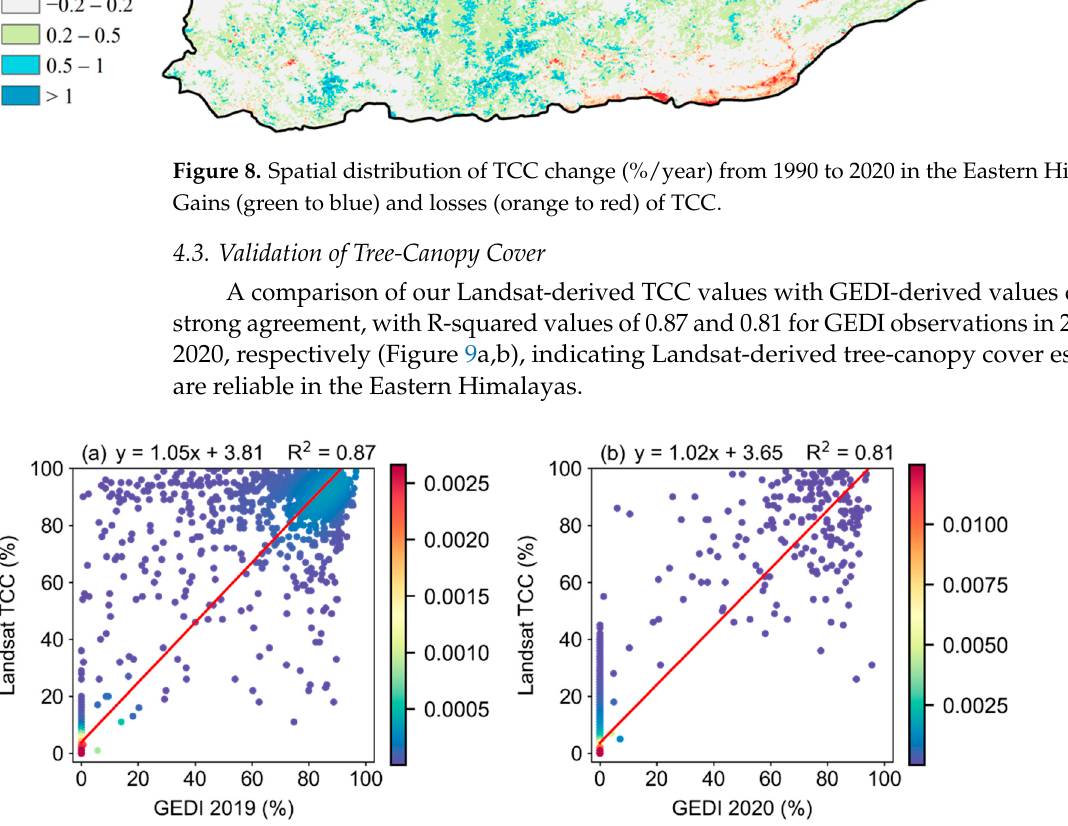
Figure 9. Comparison of TCC estimation with ( a ) GEDI 2019 observations and ( b ) GEDI 2020 ob ‐